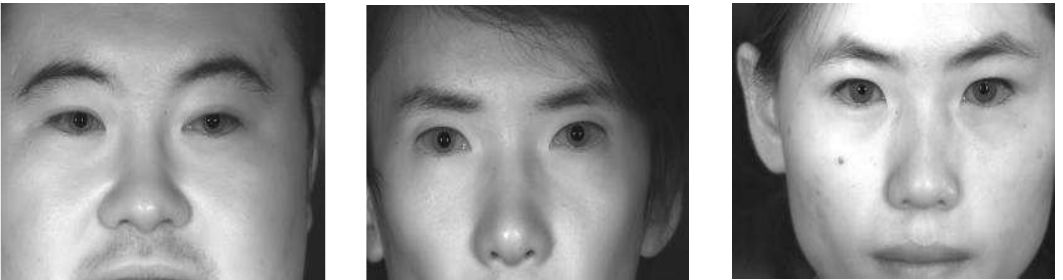
Figure 5. Example images from CASIA-Iris-Distance database.